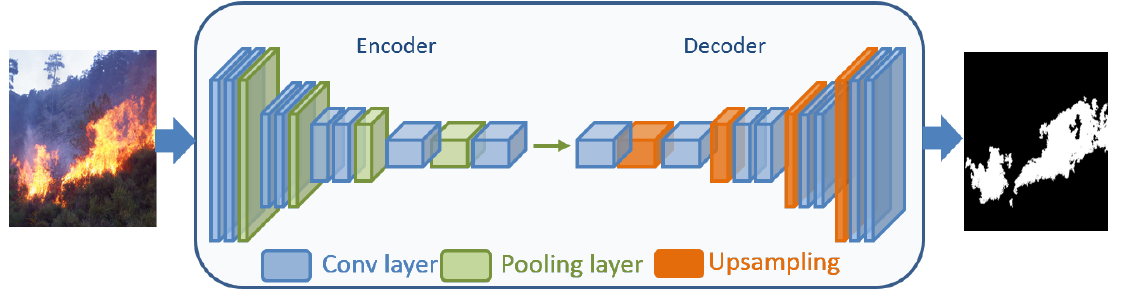
Figure 3. Wildland fire